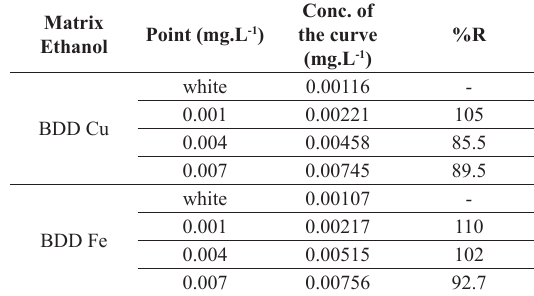
Table 5. Coefficients of variation of the means of the SWASV peaks obtained and the coefficient of variation of Horwitz. Level of Matrix fortification Ethanol